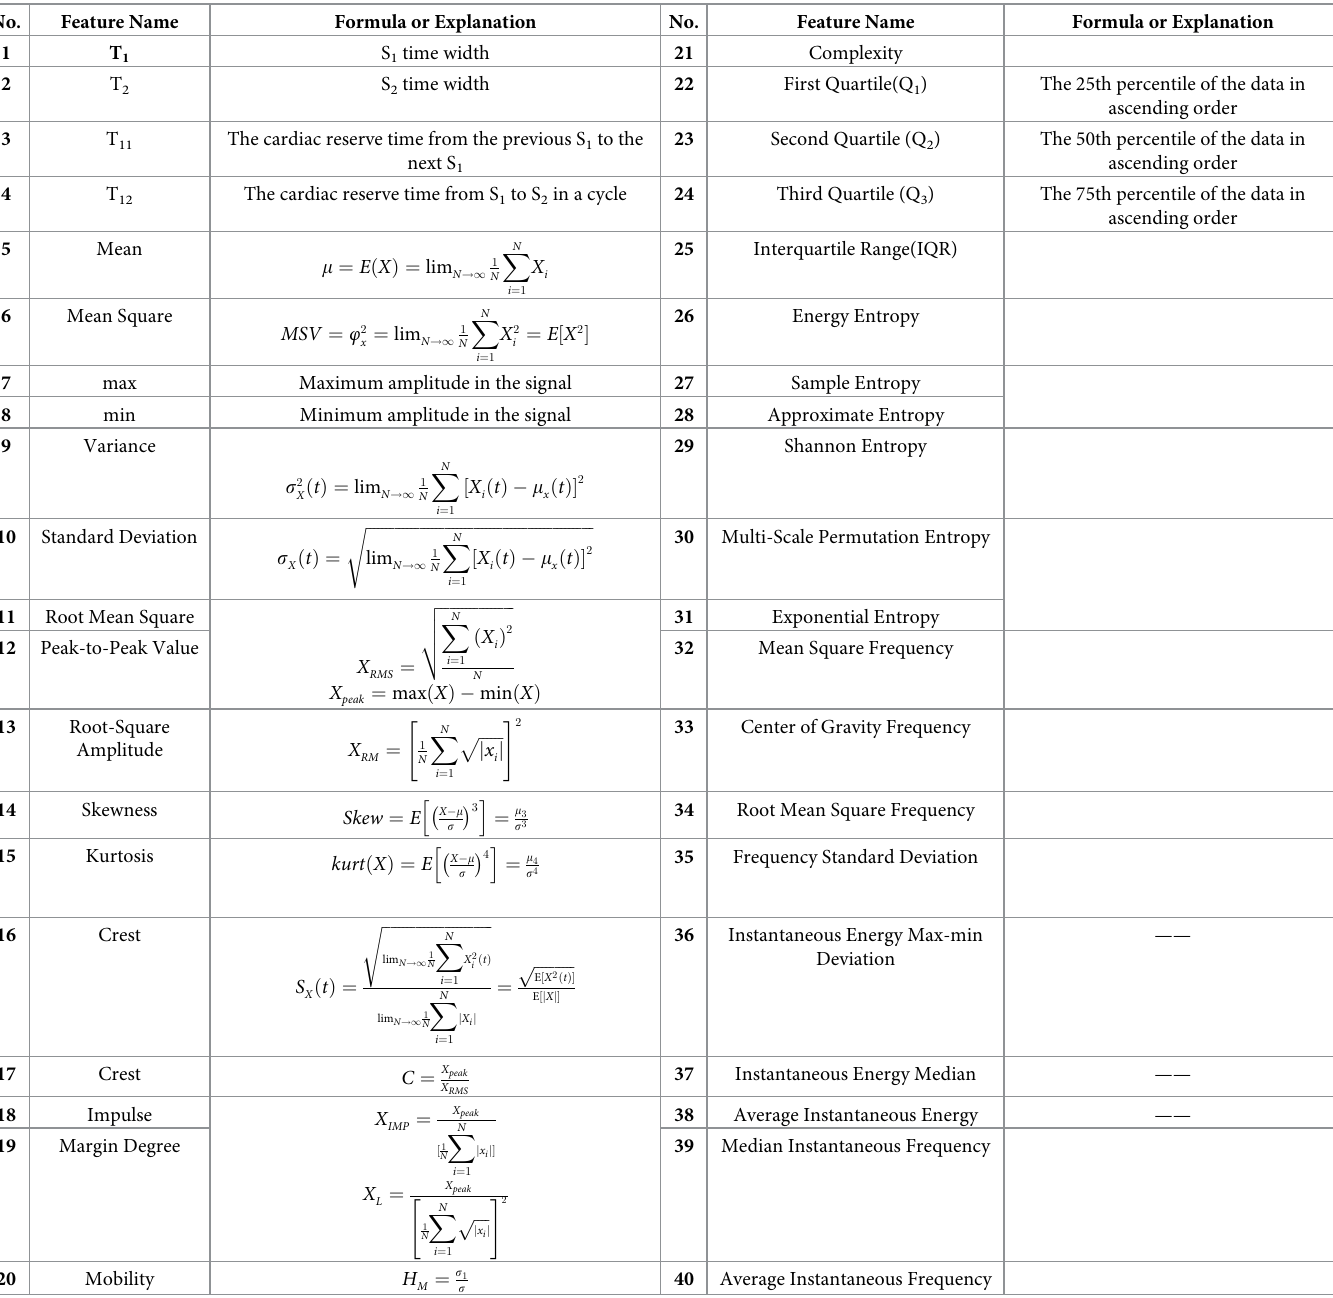
Table 1. 40 fusion